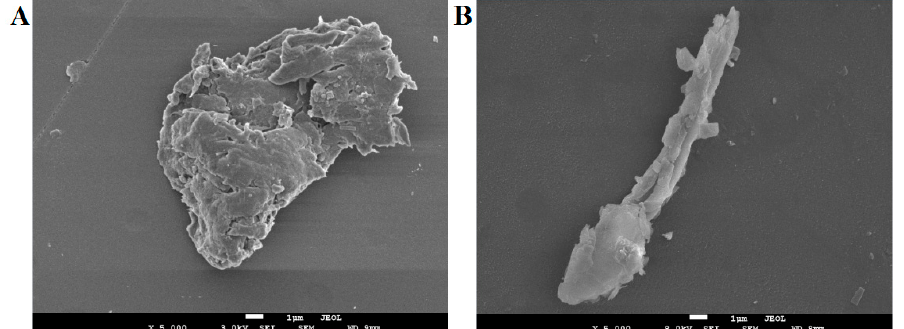
Figure 3. Scanning electron microscopy ( SEM) images of neutral fraction of total polysaccharides-II (TPN-II) ( A ) and acidic fraction of total polysaccharides-II (TPA-II) ( B ). Morphology at 5000 × (scalebar is 1 µ